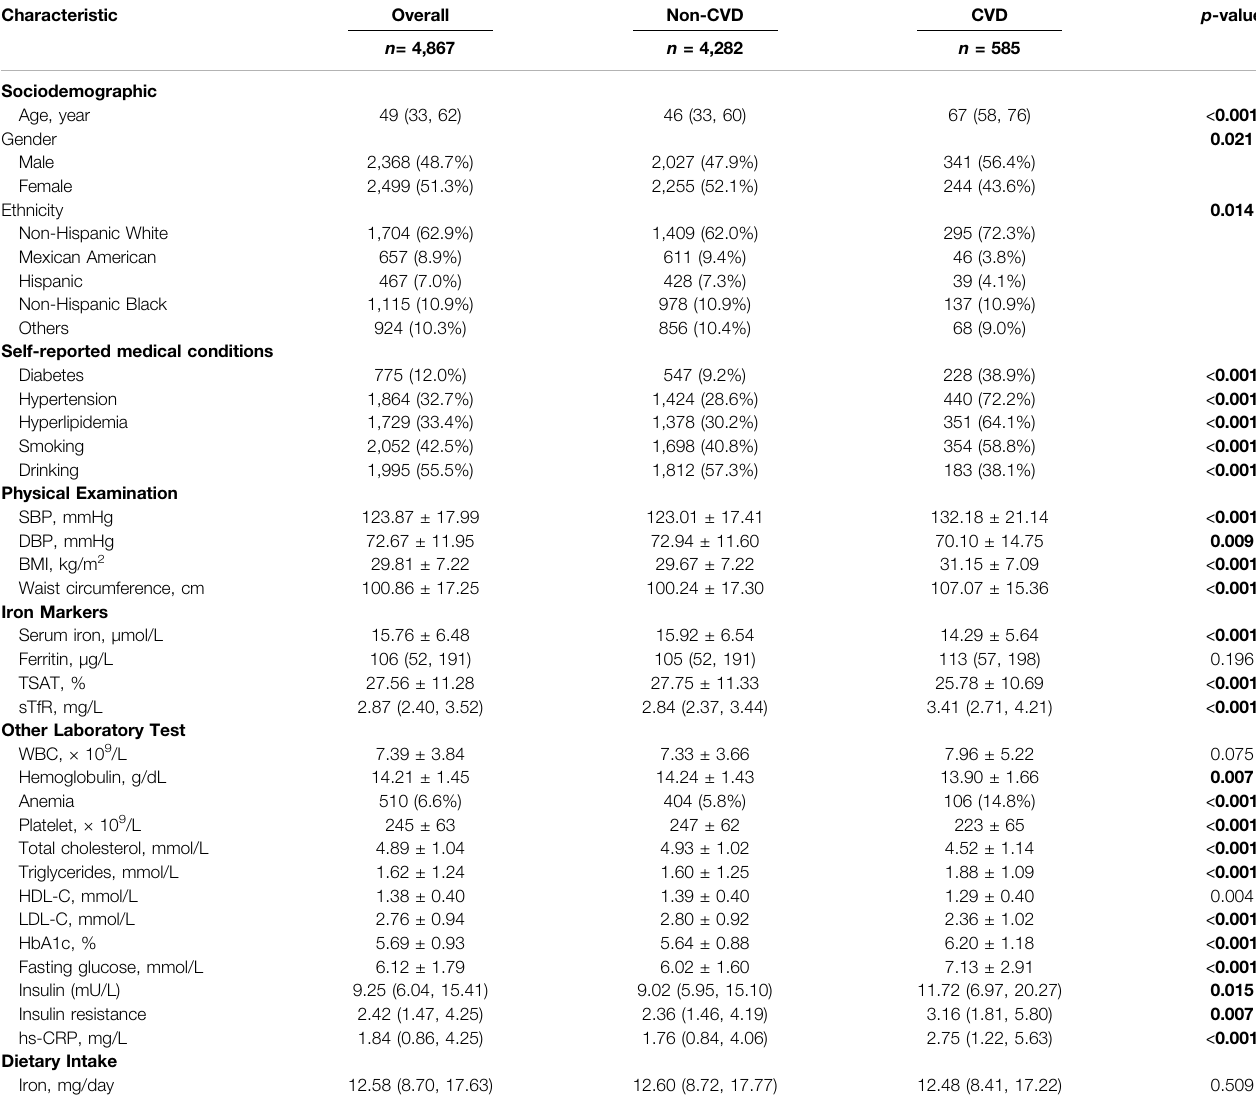
TABLE 1 | Population characteristic strati fi ed by cardiovascular diseases. Characteristic